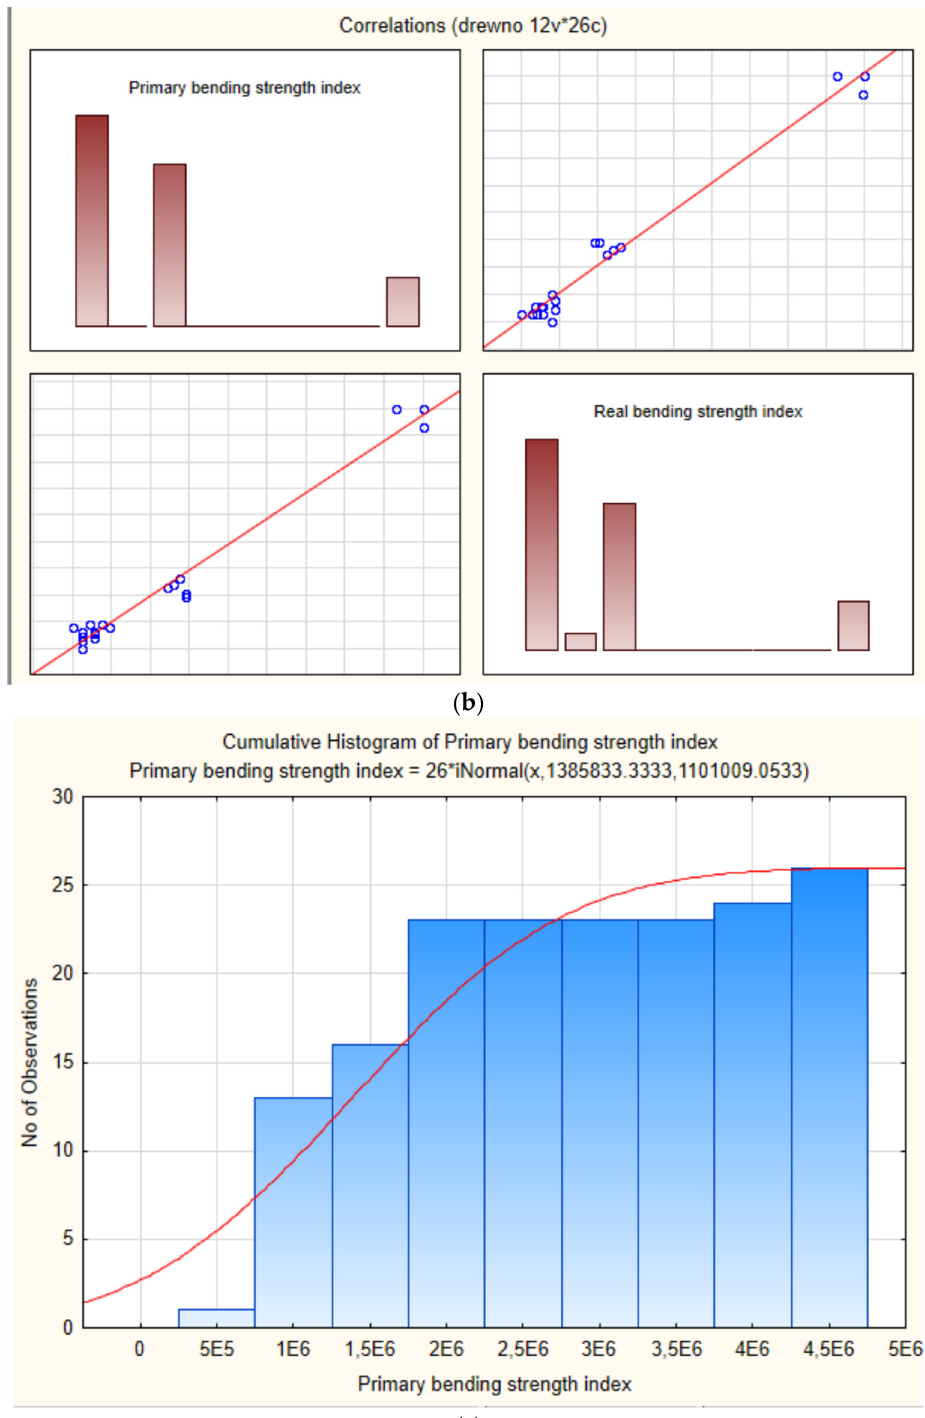
Figure 27. Statistics of the dependence of the actual strength index on the original strength index: ( a ) scatterplot primary bending strength index, ( b ) correlations, ( c ) cumulative histogram of primary bending strength index.